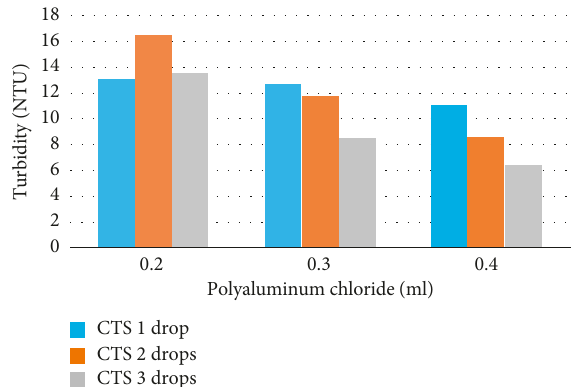
Figure 6: The effluent turbidity of raw water with chitosan and polyaluminum chloride.